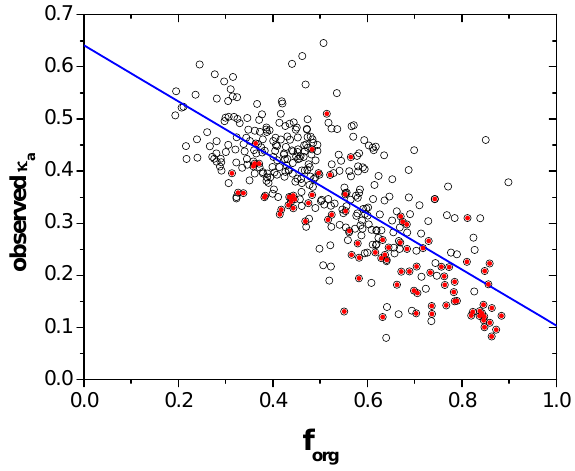
Fig. 4. Effective hygroscopicity parameters predicted from the or- ganic and inorganic mass fractions determined by AMS measure- ments ( κ a , p , Eq. (1)) plotted against the values obtained from the CCN measurements ( κ a ) observed for the entire campaign. Note that the data points at which m D < 1µgm − 3 are included. Red dots indicate the data points measured during the BBE. The diagonal grey line indicates the 1:1